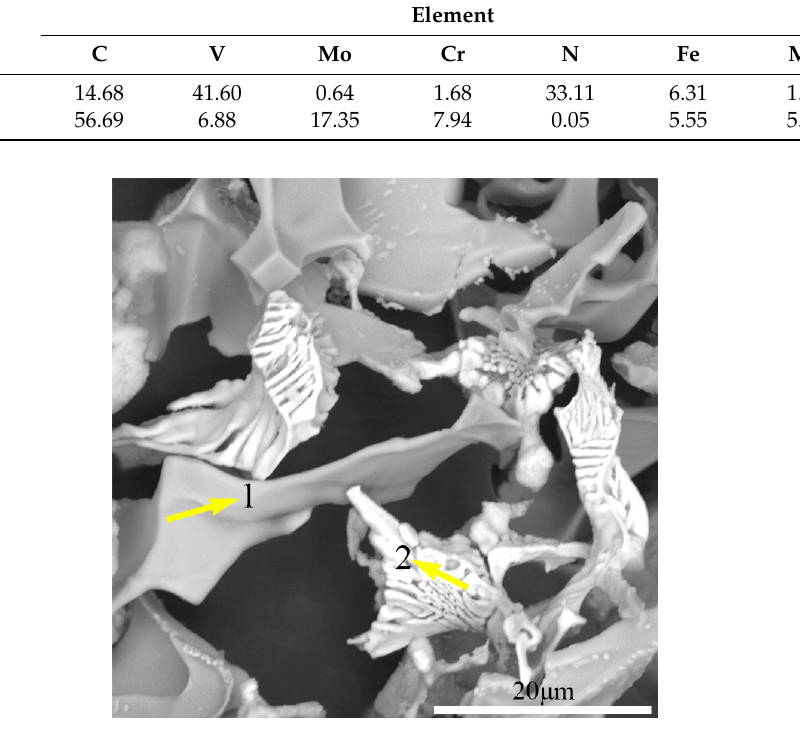
Table 5. Energy-dispersive X-ray spectrometer EDS analyzed results of carbides or carbonitrides (mass %).